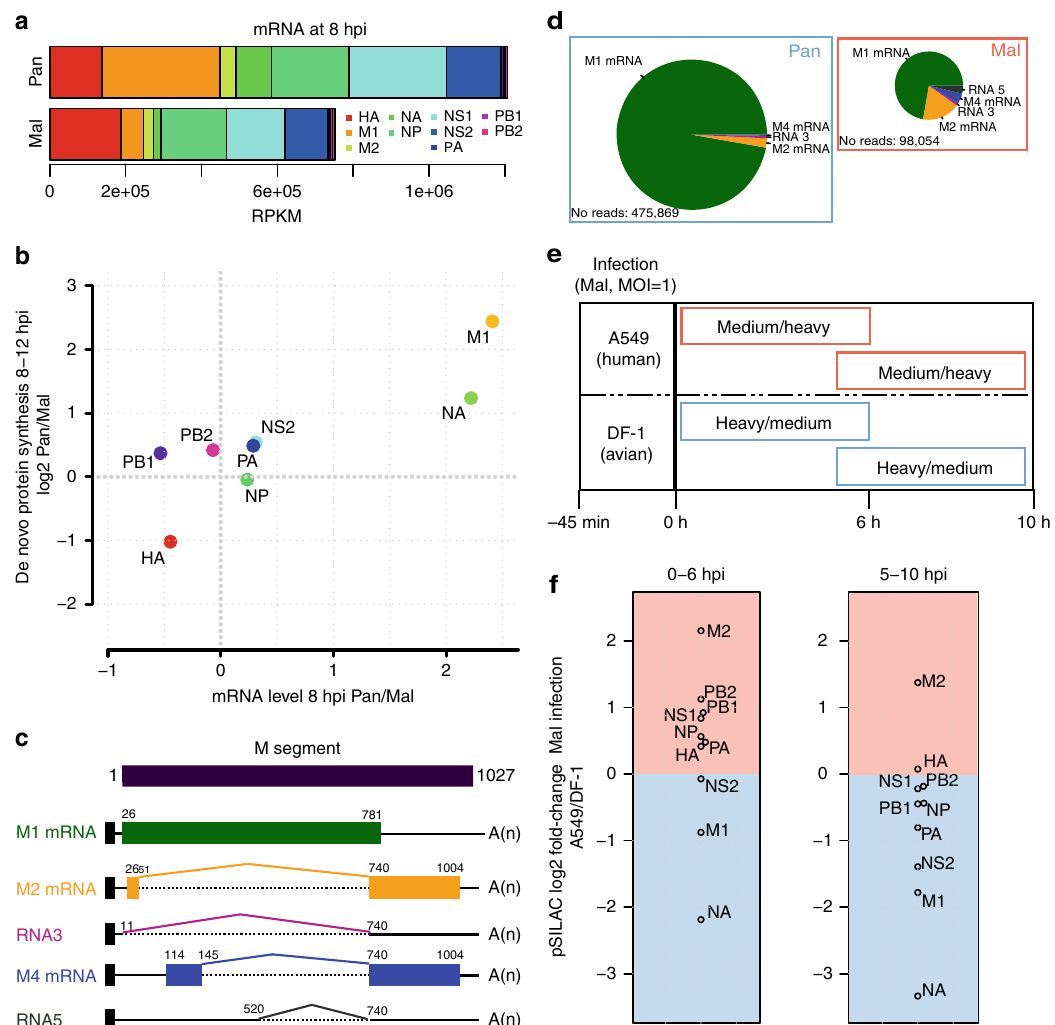
Fig. 4 Differences in M segment RNA splicing. a Normalized read counts (RPKM, based on splice junction reads and exonic reads) for 10 viral mRNAs from poly-A-enriched and either Pan- or Mal-infected samples at 8 hpi. The sum of n = 2 biological replicates is depicted. b Direct comparison of fold changes for viral mRNAs/proteins from RNA level and protein synthesis data. c Schematic depiction of the M gene architecture. The M pre-mRNA can be spliced into the indicated isoforms. d Relative quanti fi cation of the different isoforms based exclusively on splice junction reads from RNA-seq data for both strains at 8 hpi. The area of the pies re fl ects the absolute number of splice junction reads. The average of n = 2 biological replicates is depicted. e SILAC- light-labeled DF-1 and A549 cells were pulse labeled with heavy or medium heavy SILAC amino acids (in label-swap duplicates) after infection with the Mal virus (MOI = 1 PFU/cell) and subjected to quantitative shotgun proteomics. f pSILAC fold-changes are depicted for both pulse intervals comparing the production of viral proteins with the Mal strain in human vs. avian cells. The average of n = 2 biological replicates is